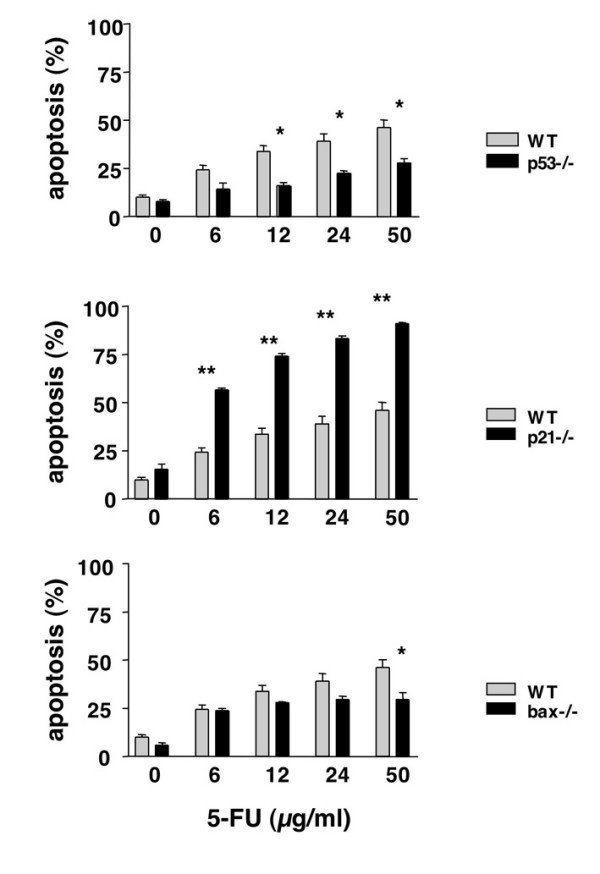
Induction of apoptosis by 5-flurouracil. HCT116 cells were cultured for 72 h in the presence of 5-FU. Grey bars: wild type. Black bars: knock-out mutants. Upper panel p53-/-, middle panel p21CIP/WAF-1-/-, lower panel Bax -/-. *: p < 0.05, **: p < 0.005.